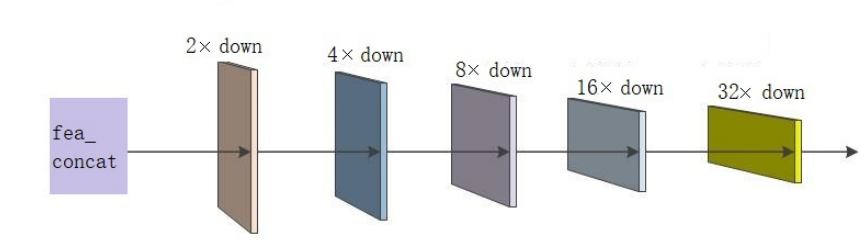
Figure 6. Reverse feature